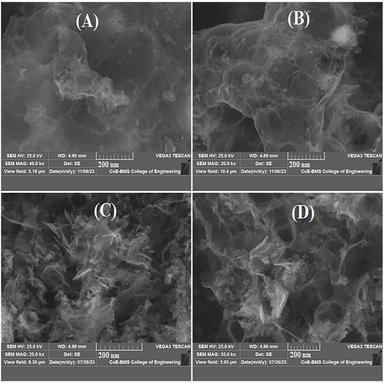
SEM micrographs of CoFe2-xSmxO4 (a) x = 0.0 (b) x = 0.050 (c) x = 0.075 (d) x = 0.1 ferrites.